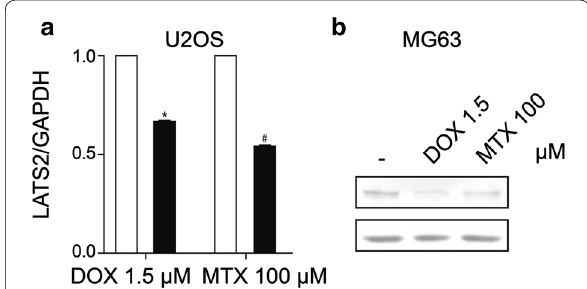
Fig. 3 LATS1/2 total protein decreases in response to MTX/DOX treatment in osteosarcoma cells. a Grayscale comparisons of LATS2 total protein to that of GAPDH in U2OS cells, according to the west‑ ern blotting results in Fig. 2c, d. The error bars represent mean SD. ± Compared with control ( t test, n 3), * P < 0.05 and # P < 0.05. LATS2 = protein level was decreased by MTX and DOX in U2OS cells. b Rep‑ resentative image of LATS1 total protein in MG63 cells treated with indicated concentrations of MTX or DOX. LATS1 protein level was decreased by MTX and DOX in MG63